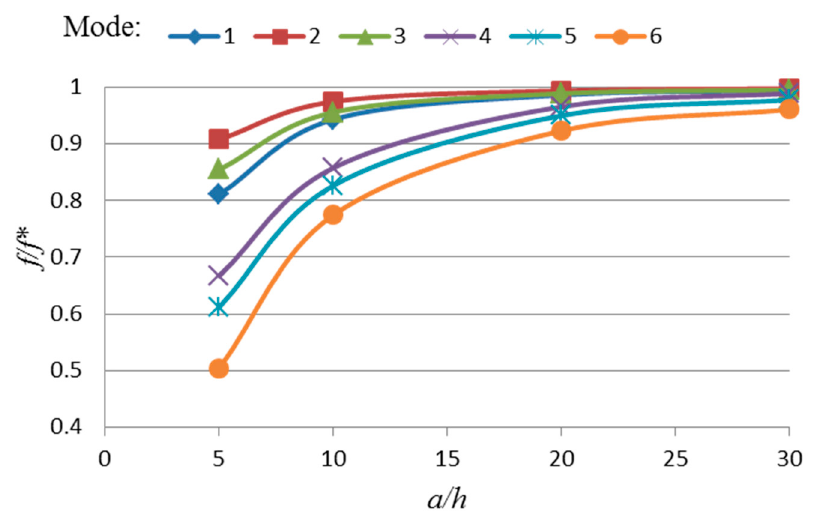
Figure 4. Relationship between normalized natural frequency and length-to-thickness ratio for the carbon/epoxy [0] 8 square plate.